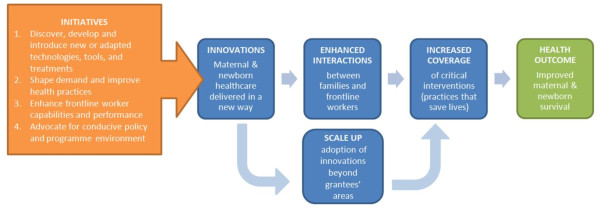
Theory of change.